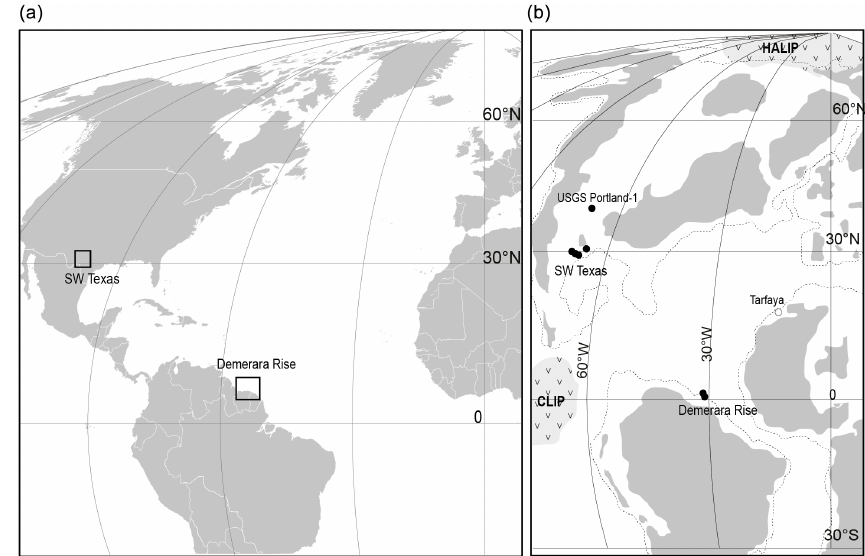
Figure 1. Site locations. (a) Present-day position of the study areas and (b) Turonian palaeogeographic reconstruction with site locations: grey shaded area, landmass; dotted line, palaeo-shelf; CLIP, Caribbean large igneous province; HALIP, high-Arctic large igneous province. Boxes show study area as presented in Fig.